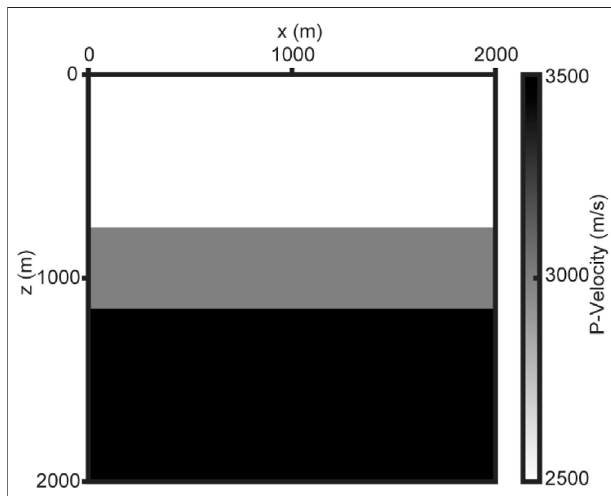
FIGURE 2 | The three-layer horizontal P-wave velocity model. The P-wavevelocities ofthe three layers from top to bottom are 2,500, 3,000, and 3,500 m/s, respectively. The depths of the two interfaces are 750 and 1,150 m, respectively.